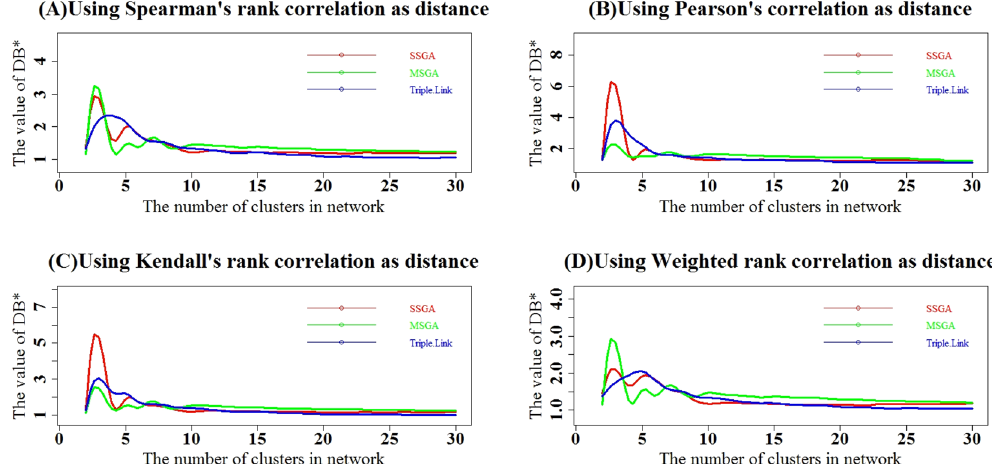
Figure 7. Comparison of subnetworks derived from SSGA, MSGA and Triple-Link Algorithm with DB * indices. The DB * indices of top i subnetworks derived from SSGA, MSGA and Triple-Link Algorithm where i = (2, … , 29, 30). ( A ) The distances were calculated based on Spearman rank correlation; ( B ). The distances were calculated based on Pearson product-moment correlation; ( C ). The distances were calculated based on Kendall’s rank correlation; ( D ). The distances were calculated based on Weighted rank correlation. In all the cases, the higher XE of top i subnetworks reflects a tighter average coordination of the top i subnetworks.